Question: Which visualization type does this figure use?
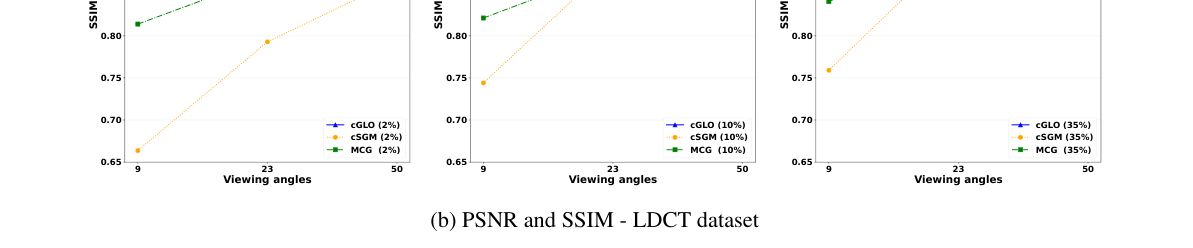
Answer: line